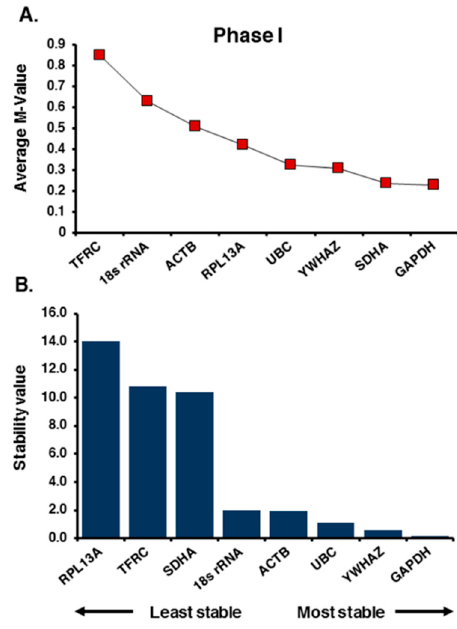
Figure 1. Expression stability analysis of the candidate reference genes in phase I. The stability of expression for 8 housekeeping genes tested in saliva is ranked (left to right) based on the least stable to the most stable gene by: ( A ) geNorm; and ( B ) NormFinder algorithms.